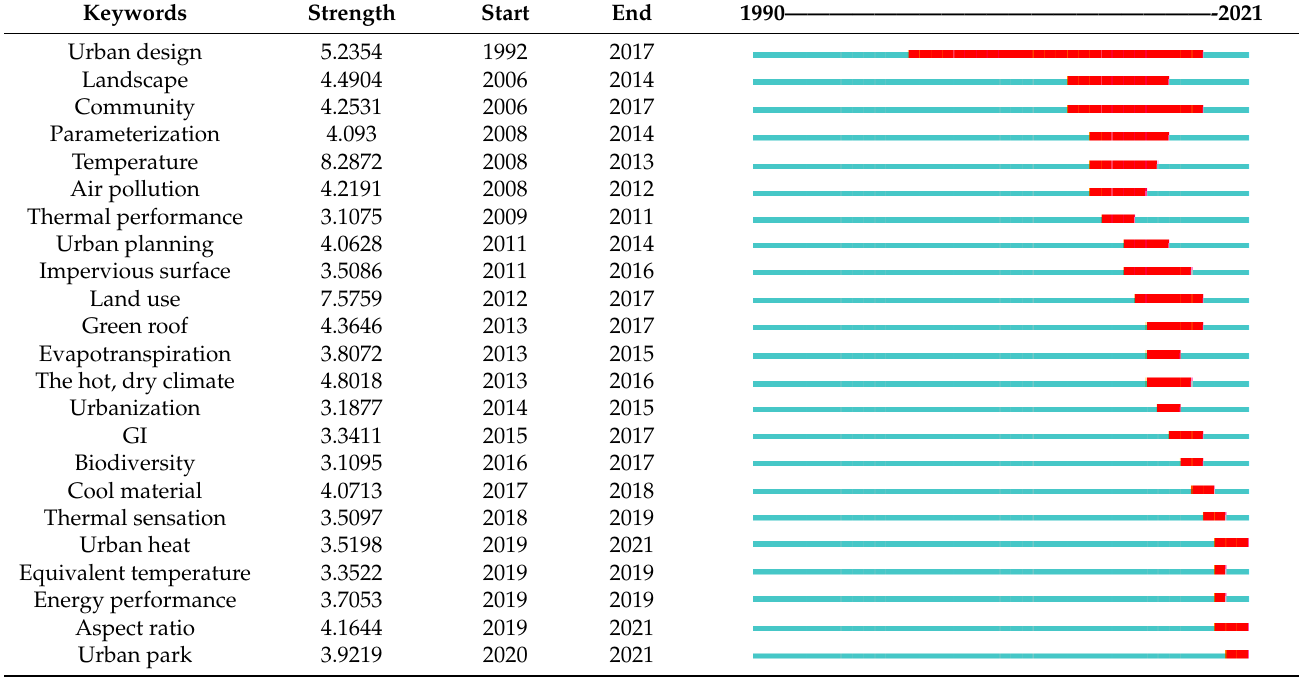
Table 2. Top 24 most cited keywords in urban microclimate research in 1990–2021.